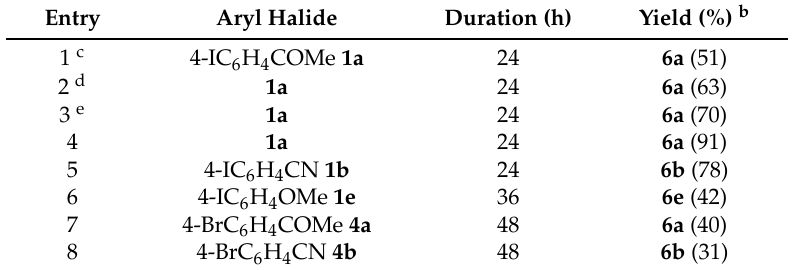
Table 4. Pd-catalyzed Stille coupling of aryl halides ( 1 or 4 ) and tetramethylstannane ( 5 ) in water a . Entry Aryl Halide Duration